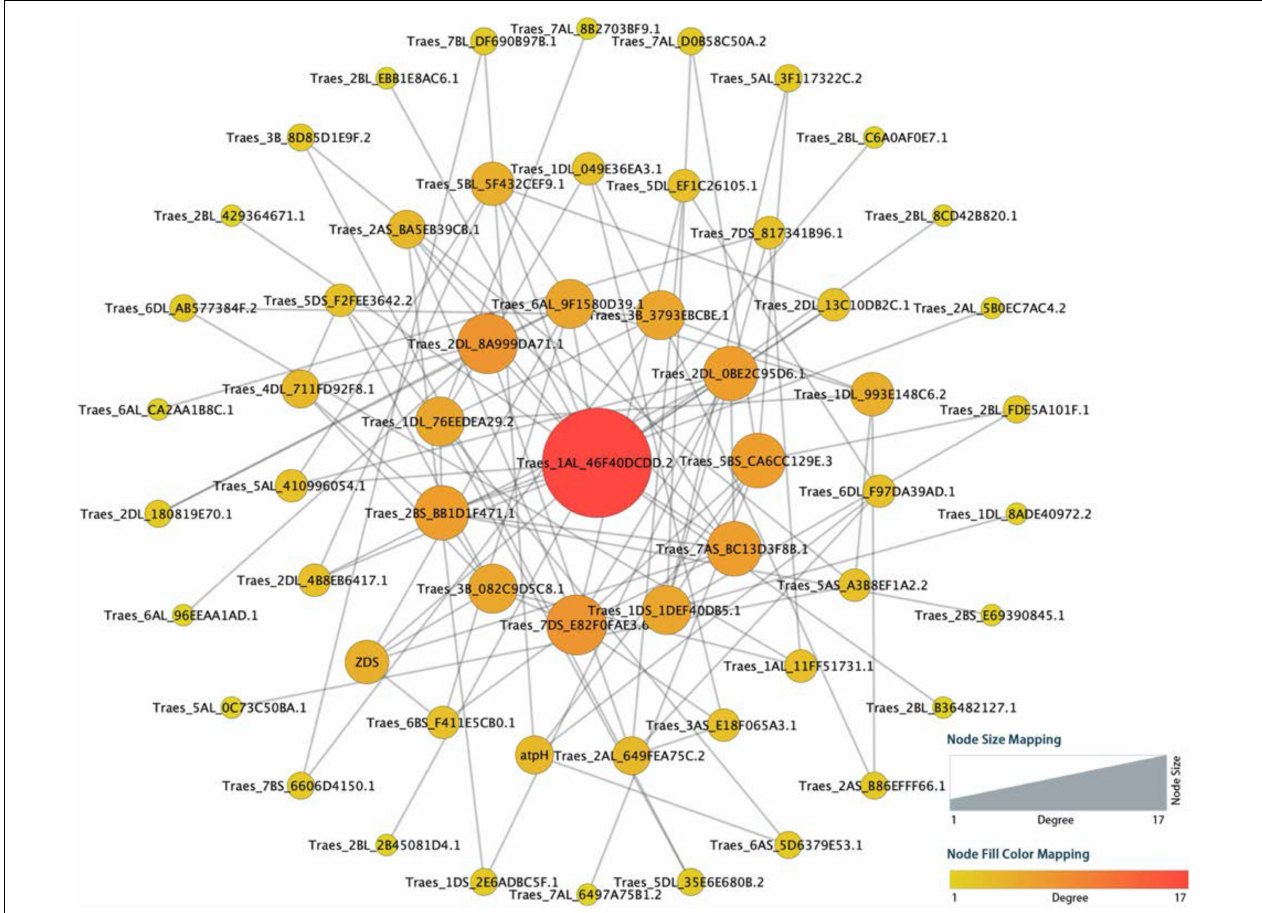
FIGURE 3 | Protein–protein interaction (PPI) regulatory network for the selected candidate genes among high-altitude genotypes. The circles represented queried proteins, and the lines represented protein–protein